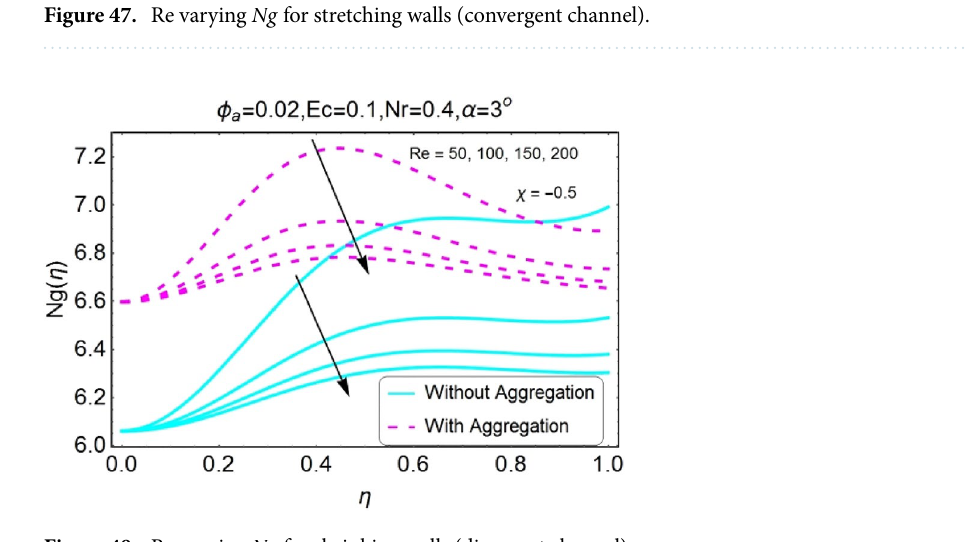
Figure 48. Re varying Ng for shrinking walls (divergent